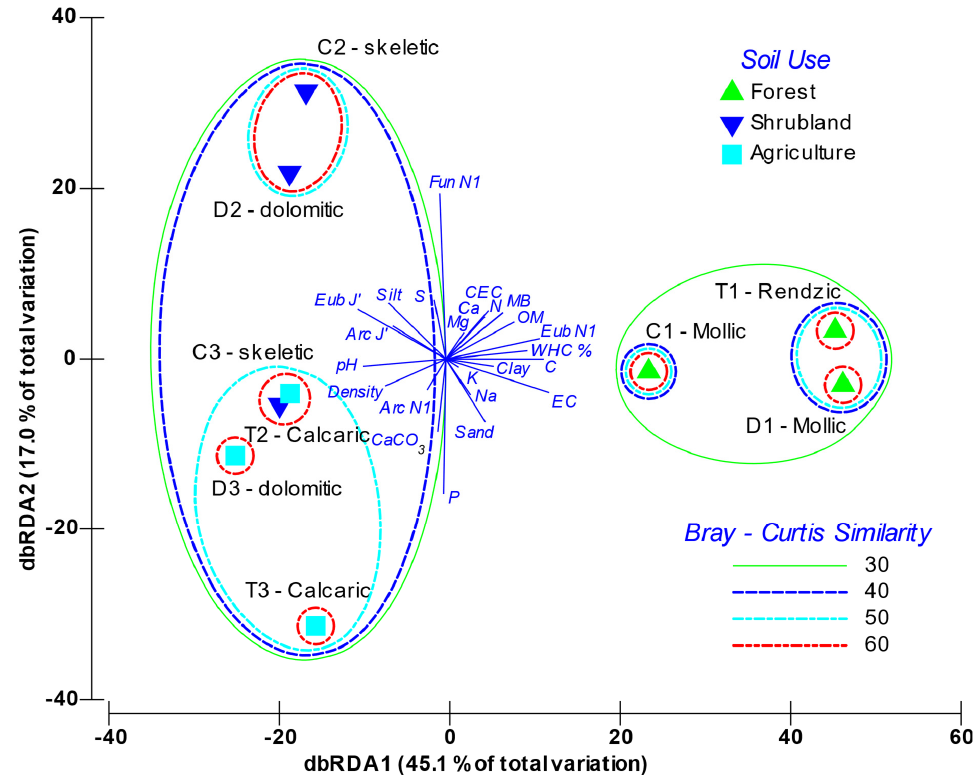
Figure 4. Distance-based redundancy analysis (db-RDA) triplot between environmental variables and the fingerprinting profiles of the A-horizon soil samples. Soils are labelled as parent material (T: Marl and limestone; C: Limestone; D: Dolo- mites) and soil use (1: Forest; 2: Shrubland; 3: Crops). EC: Electrical Conductivity; WHC: Water Holding Capacity; CEC: